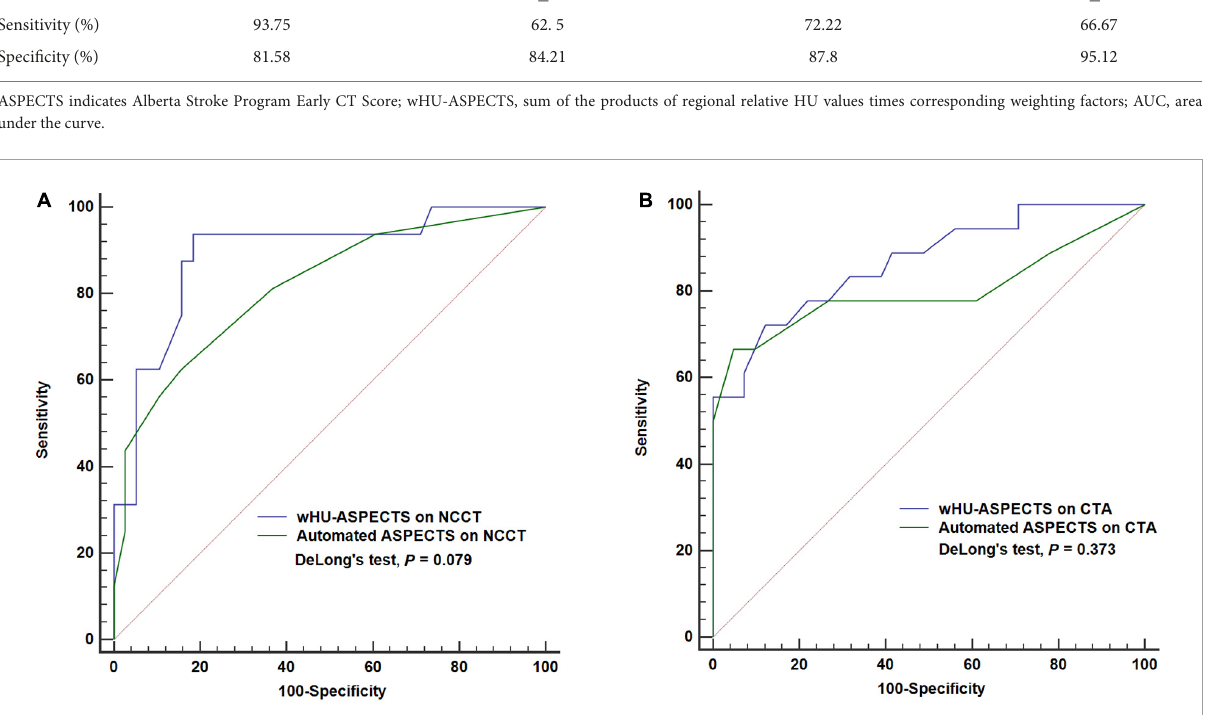
FIGURE4 ROC analysis of attenuation changes vs. automated ASPECTS to classify ischemic core volume ≥ 70 ml. (A) The wHU-ASPECTS on NCCT image had an AUC of 0.891 ( P < 0.001), not significantly different from automated NCCT-ASPECTS (AUC = 0.817, P < 0.001), with DeLong’s test analysis ( P = 0.079). (B) The wHU-ASPECTS on CTA source image had an AUC of 0.867 ( P < 0.001), not significantly different from automated CTA-ASPECTS (AUC = 0.799, P < 0.001), according to DeLong’s test analysis ( P = 0.373). ASPECTS indicates Alberta Stroke Program Early CT Score; wHU-ASPECTS, sum of the products of regional relative HU values times corresponding weighting